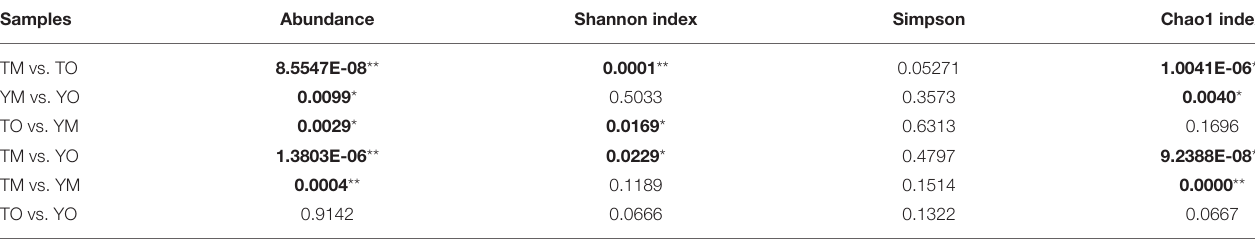
TABLE 1 | ANOVA results for the difference of fungal abundance, richness, and diversity between the O horizon and M horizon. Samples